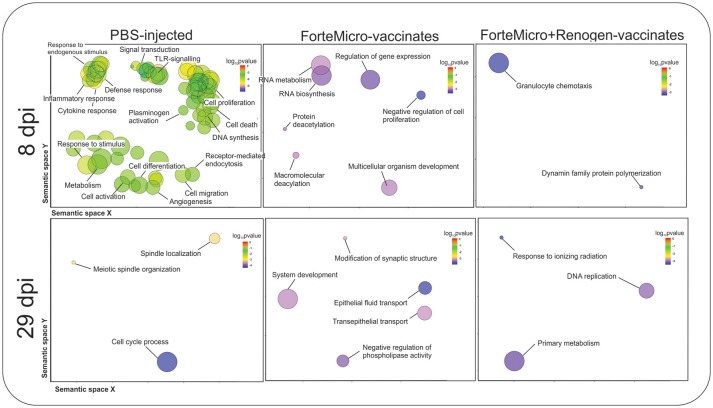
Biological processes in Sham, ForteMicro®- and ForteMicro®+Renogen®-vaccinates at 8 and 29 dpi as revealed by analysis of GO term distribution using GOrilla and REVIGO algorithms. GO terms are represented by circles and are plotted according to semantic similarities to other GO terms (adjoining circles are most closely related). Circle size is proportional to the abundance of the GO term in the list, while color indicates log10 p-values. Only GO terms with higher than 1% frequency are shown.